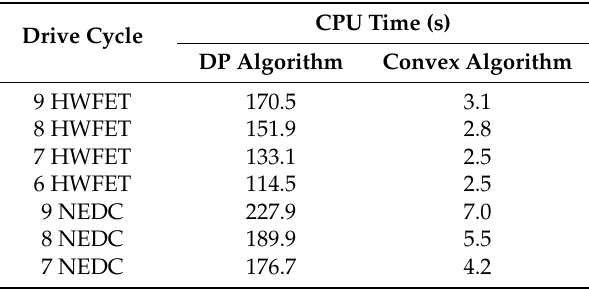
Table 4. Computation time comparison with standard initial SOC.